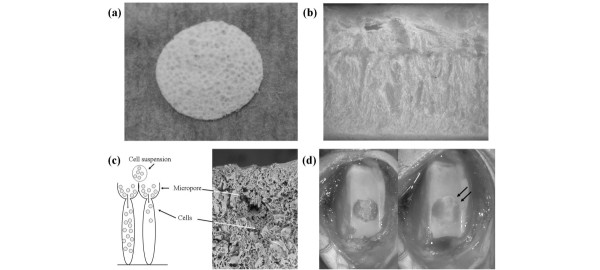
The three-dimensional poly(lactic-glycolic acid) (3D-PLGA) scaffold. The micropore side (cell seeding side) (a) and a cross section (b) of the scaffold. Schematic illustration of cell seeding (left) and scanning electron photomicrograph of cross section of cells seeded in the 3D-PLGA scaffold (right) (c). The cells lie in a uniform array at the palisades, similar to hyaline cartilage. Gross appearance of a cartilage defect in the patella groove implanted with a complex between adherent bone marrow cells and 3D-PLGA scaffold (d). The arrows indicate cell/PLGA scaffold.